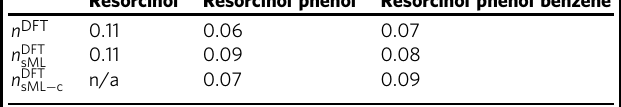
molecular datasets evaluated on the resorcinol test